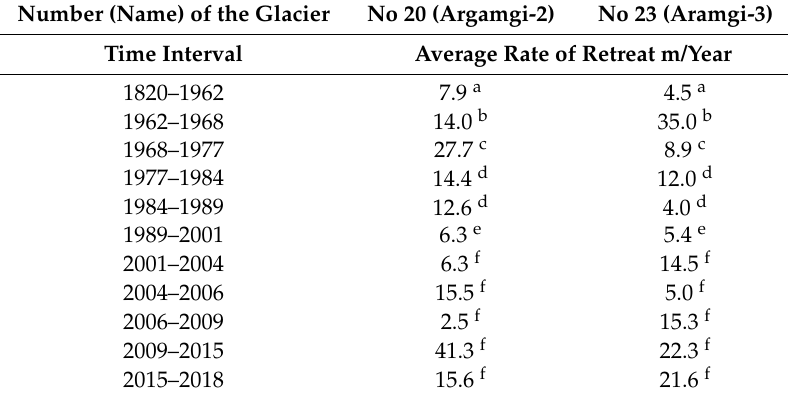
Table 5. Recession of the glaciers of the north slope of Tavan Bogd.